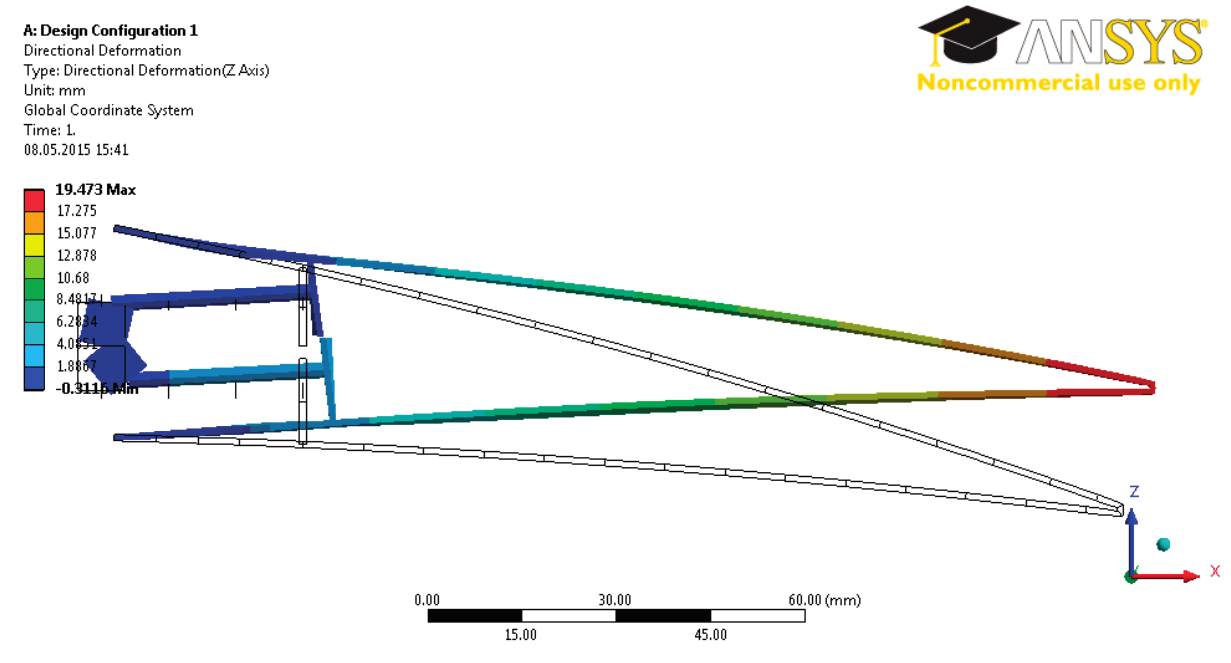
Figure 20. Deformation along Z -axis for design configuration